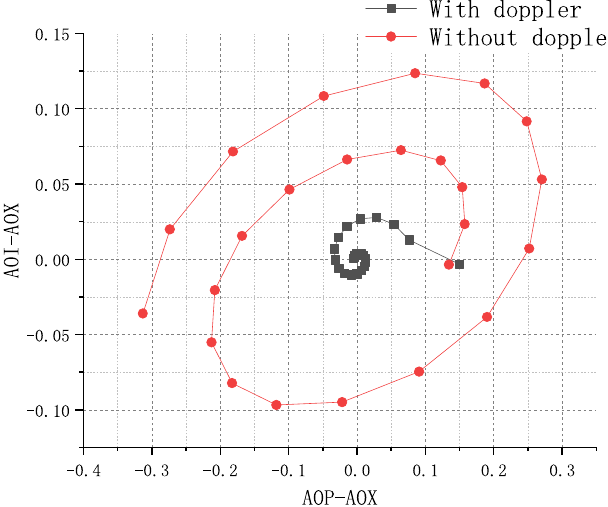
Fig. 8. Shimazu ’ s representation with/without Doppler